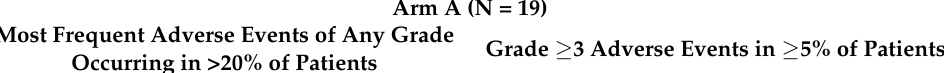
Figure S4). Median PFS2 comparison by race: 20.5 months (95% CI: 5.5, NA) for African Americans versus 11.7 (95% CI: 6.2, 21.6 for Whites ( p = 0.3242); by gender: 11.5 months (95% CI: 4.8, 18) for females versus 21.6 months (95% CI: 8.3, 26.3) for males ( p = 0.1797); and by histology: 18 months (95% CI: 10.1, 26.3) for DTC compared to 13.8 months (95% CI: 3.7, 21.6) for MTC ( p = 0.1051).